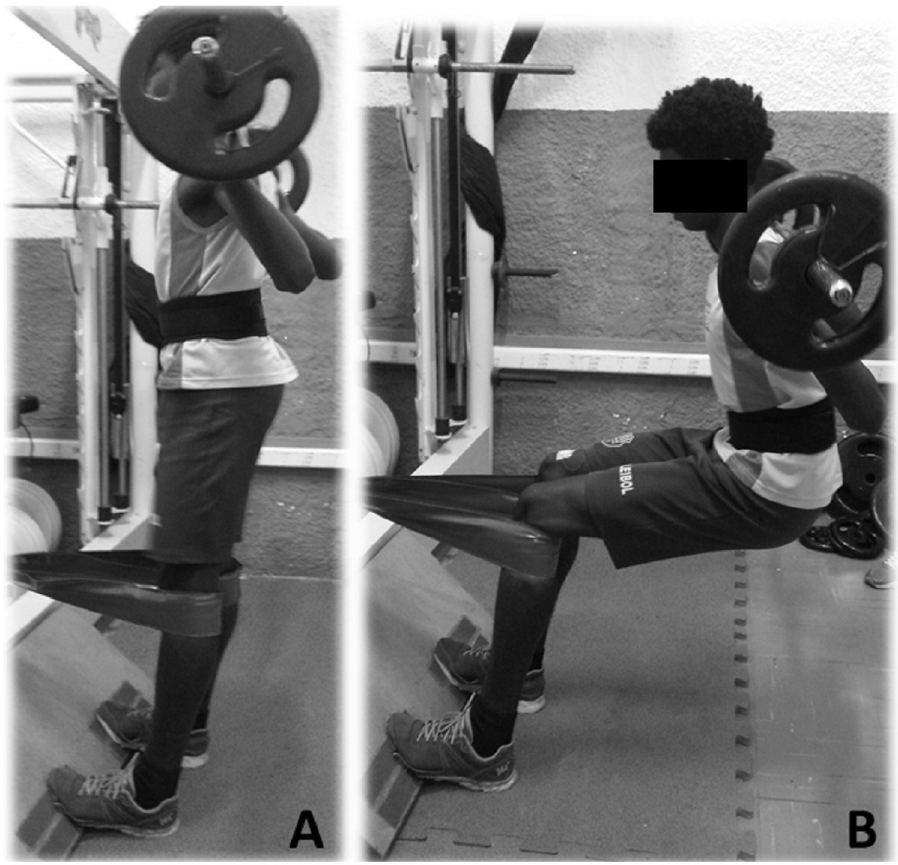
Fig 2. Half-squat exercise with eccentric emphasis performed with the Tirante Musculador 1 . A: Initial position of the movement; B: Final position of the